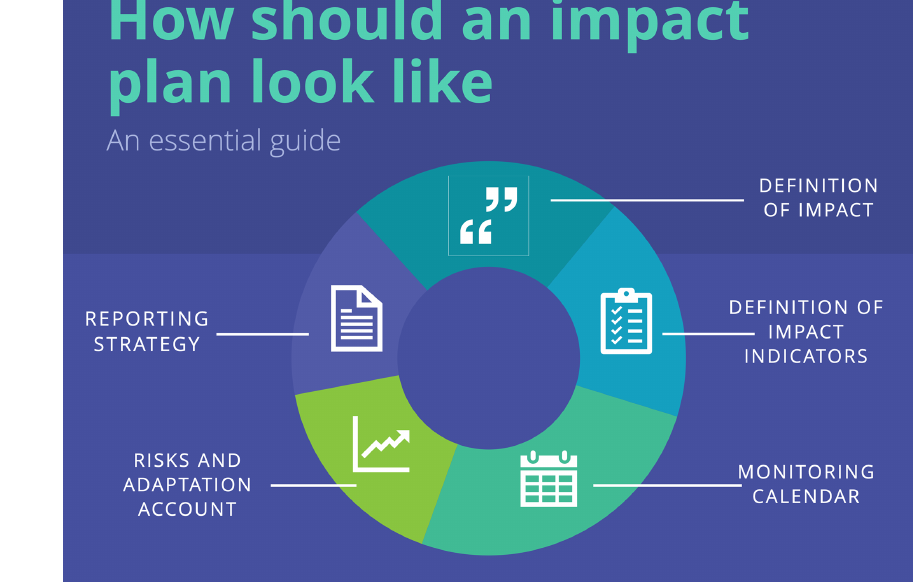
Figure 5. Graphic illustrating the five essential elements of an impact assessment